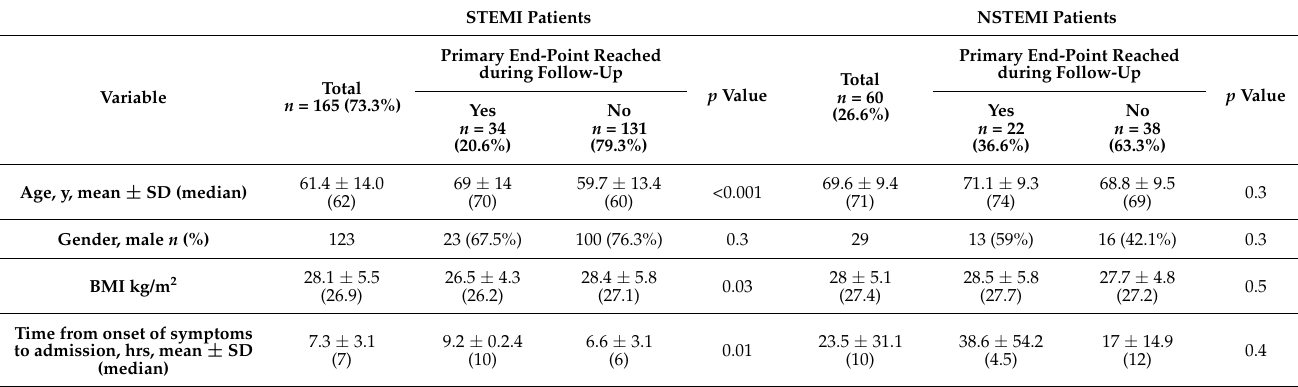
Table 2. Separate analysis of STEMI and NSTEMI populations in regard to clinical and biochemical characteristics and occurrence of